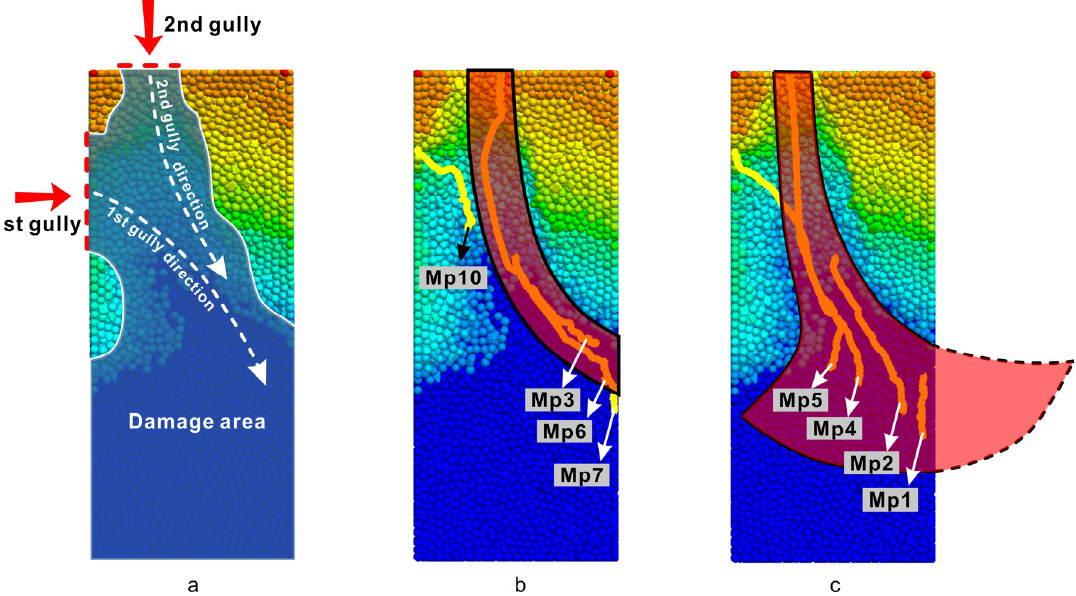
Figure 18. Gully distribution and accumulation mode. ( a ). Two gully directions; ( b ). Erosion trend-arc trend; ( c ). Erosion trend-alluvialfan trend.